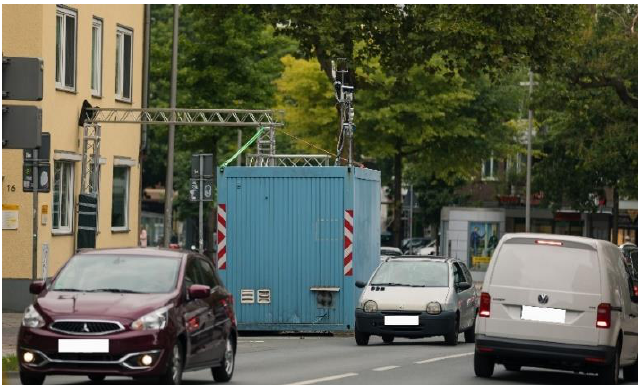
Figure 3. The container hosting the measurement station on Bült in a parking space in front of number 16. The container is equipped with measuring instruments on top.